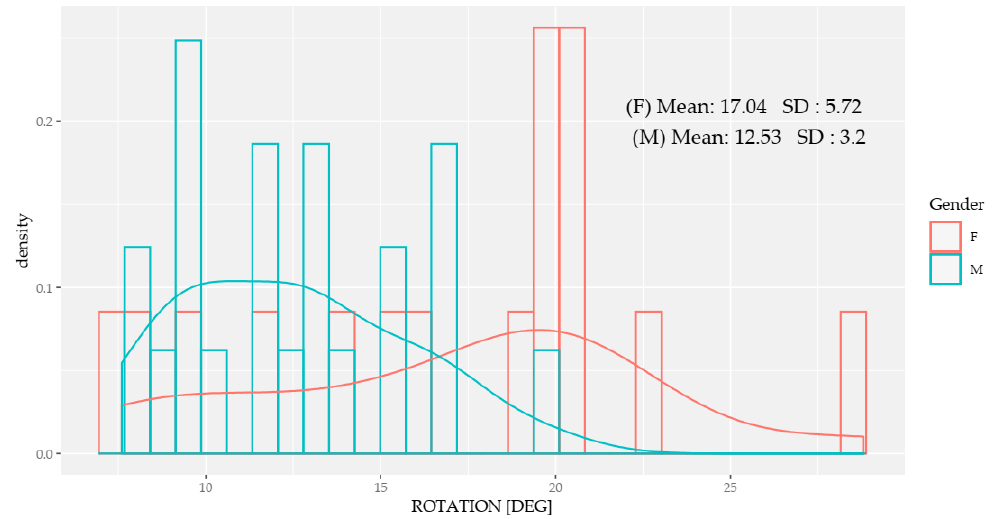
Figure 2. Variation of the rotation between women (F) and men (M), with each bar representing one participant. The lines summarize the distribution of the mean.